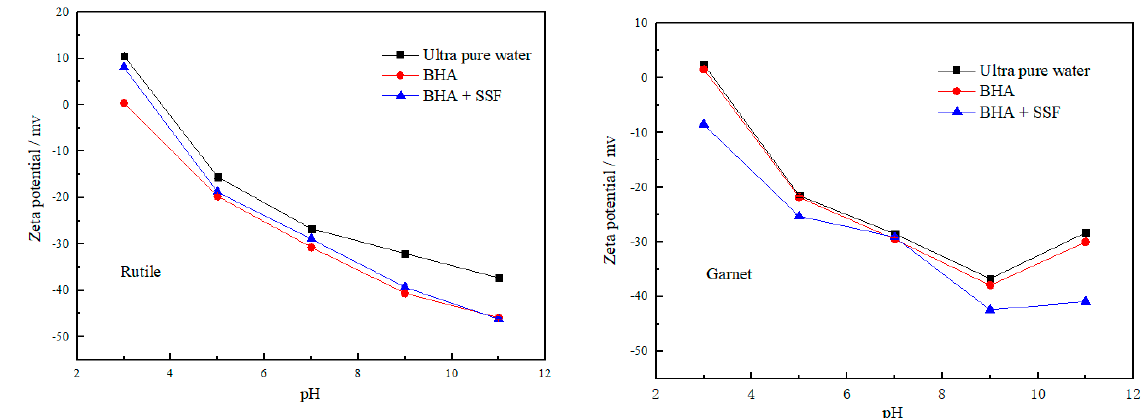
Figure 14. Effects of different reagents on the zeta potential of rutile and